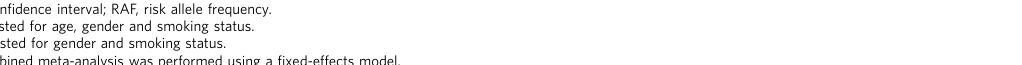
CI, confidence interval; RAF, risk allele frequency. *Adjusted for age, gender and smoking status. w Adjusted for gender and smoking status. z Combined meta-analysis was performed using a fixed-effects